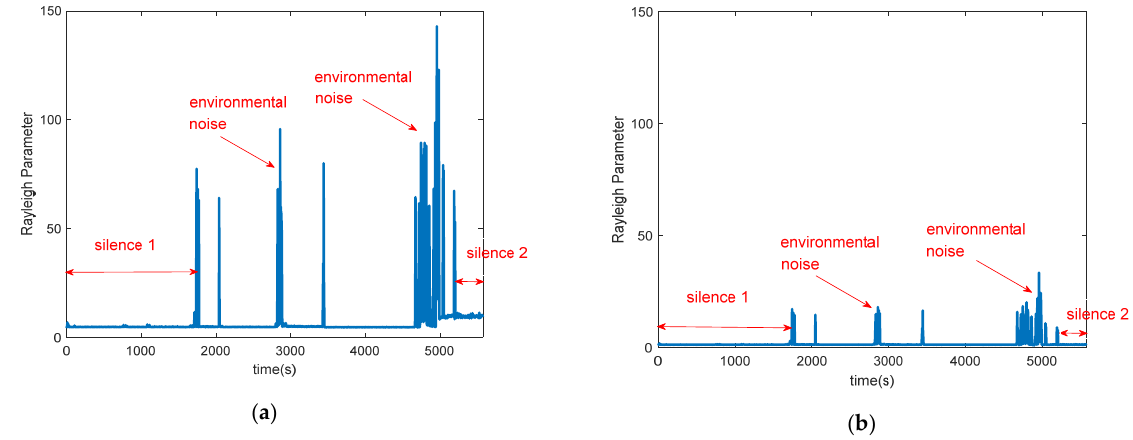
Figure 4. The amplitude of CSI and the conjugate multiplication between the CSI of two antennas after removing the noise of AGC. ( a ) The amplitude of CSI and conjugate multiplication between the CSI of two antennas after removing the noise of AGC in the silence environment; ( b ) the amplitude of conjugate multiplication between the CSI of two antennas after removing the noise of AGC.